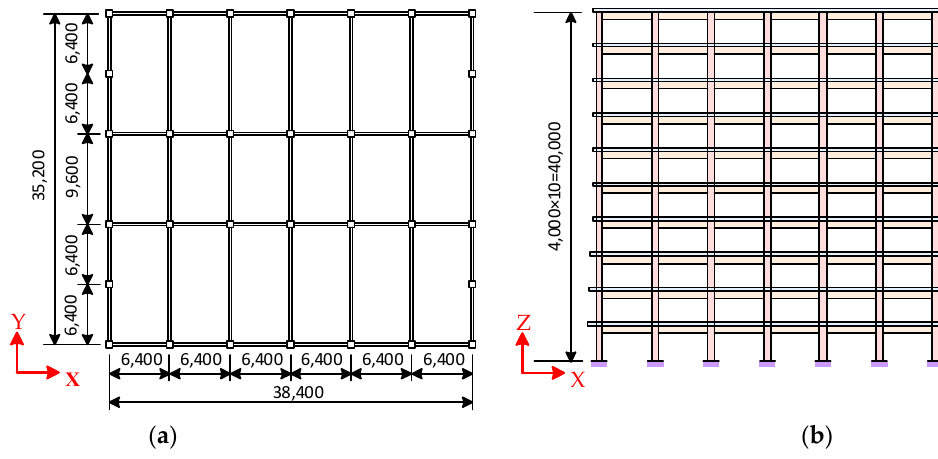
Figure 4. The layout of the structure [40] (unit: mm): ( a ) plan layout; ( b ) elevation layout.